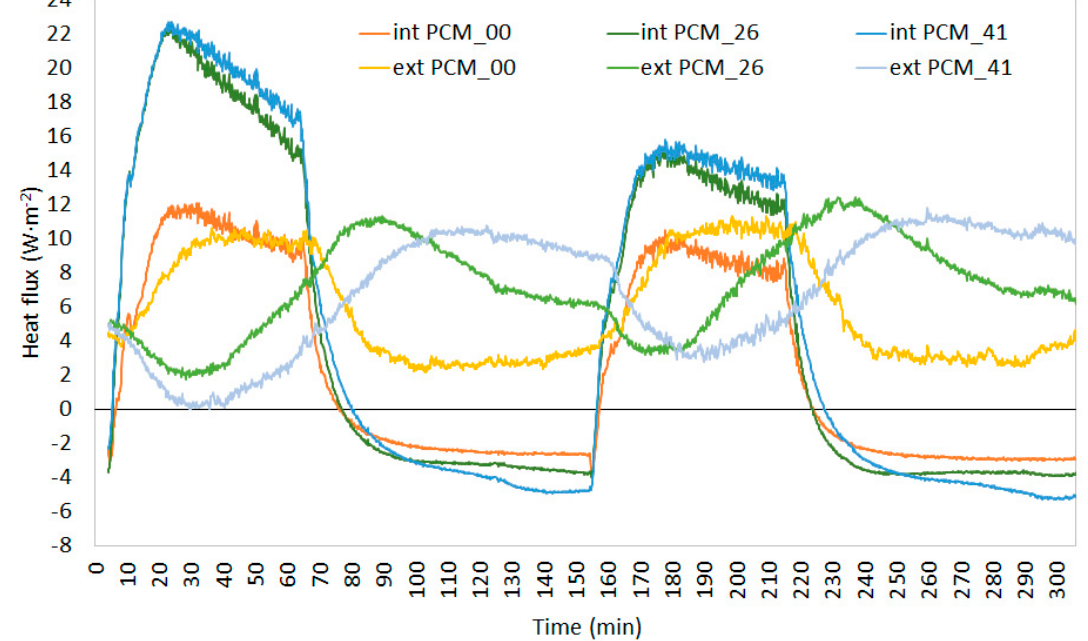
Figure 13. Specific heat flux through the internal (int) and external (ext) specimen